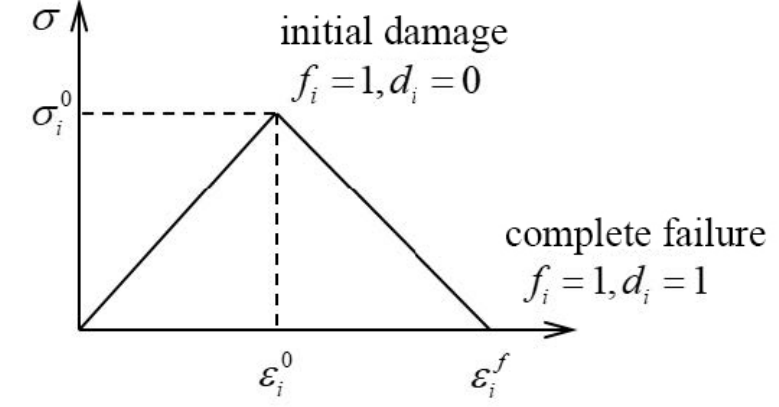
Figure 8. Stiffness degradation model of linear elastic materials.